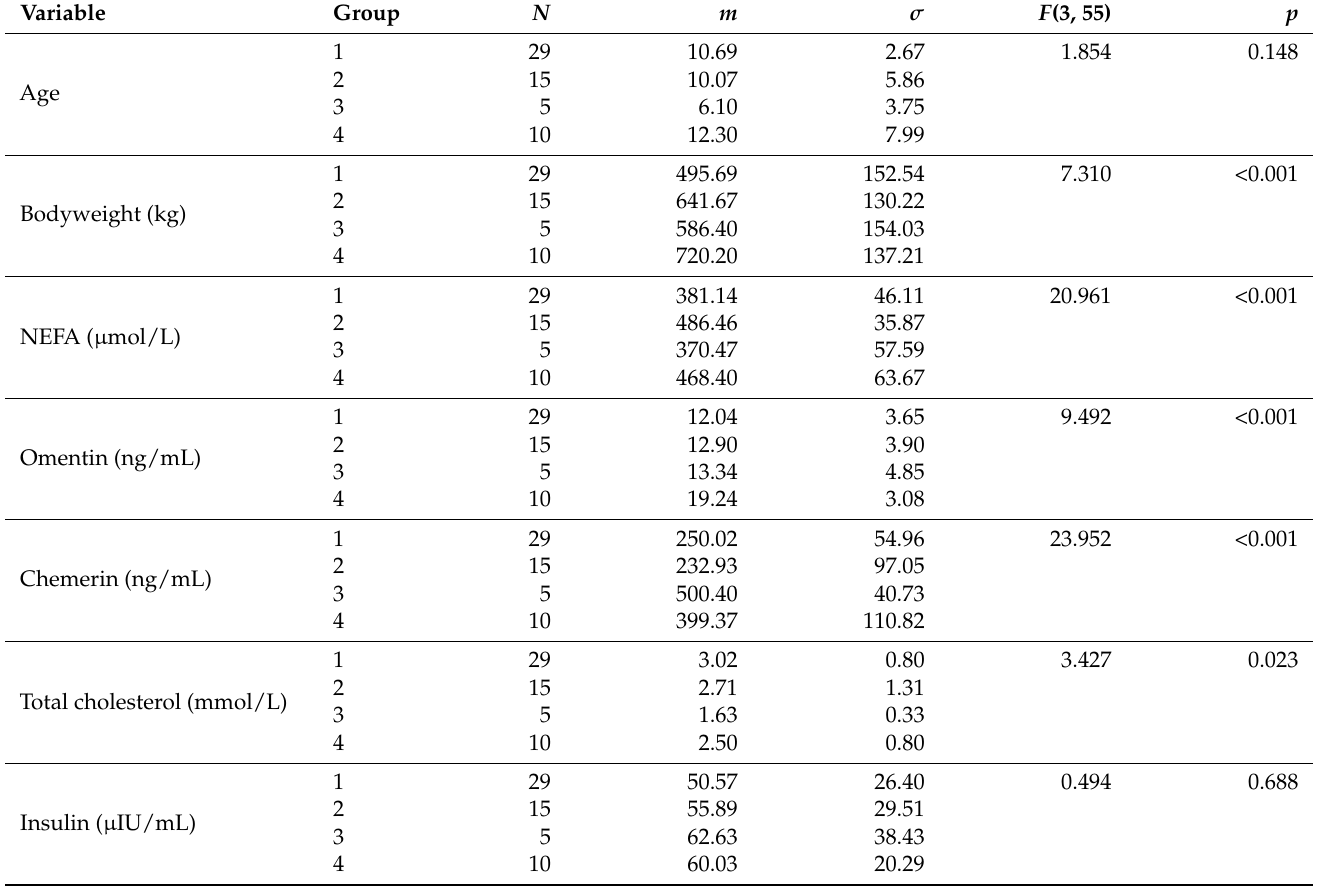
Table 5. Comparison of means between groups by the one-factor ANOVA